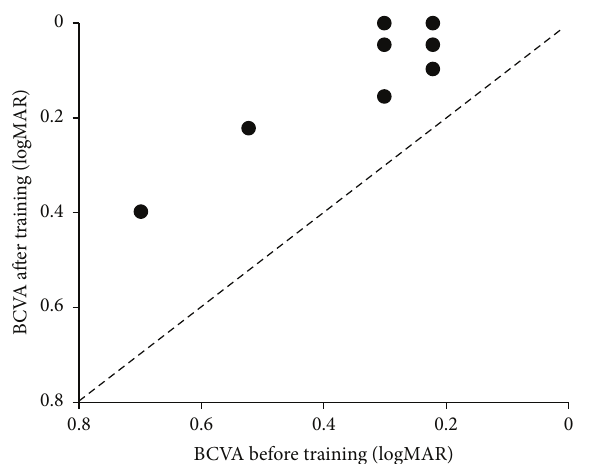
Figure 4: Scatter plot of fixation stability before and after MAIA biofeedback